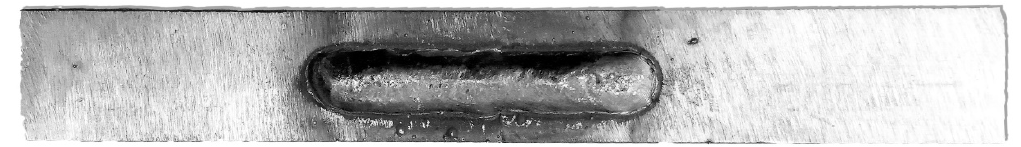
Figure 7. Macroscopic view of the bead-on-plate weld.